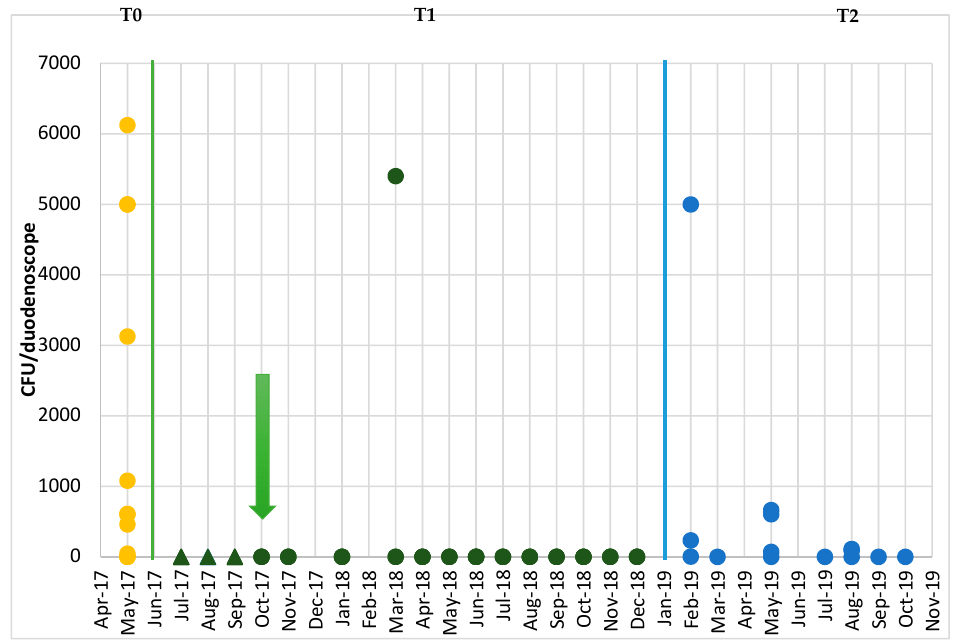
Figure 2. Temporal trend in the total concentrations (CFU/duodenoscope) recorded in the duodenoscopes throughout the period of microbiological surveillance. Green arrow: Date of return of the duodenoscopes from the manufacturing company. Dark green triangles: Substitute duodenoscopes. Dots: Duodenoscopes under surveillance.